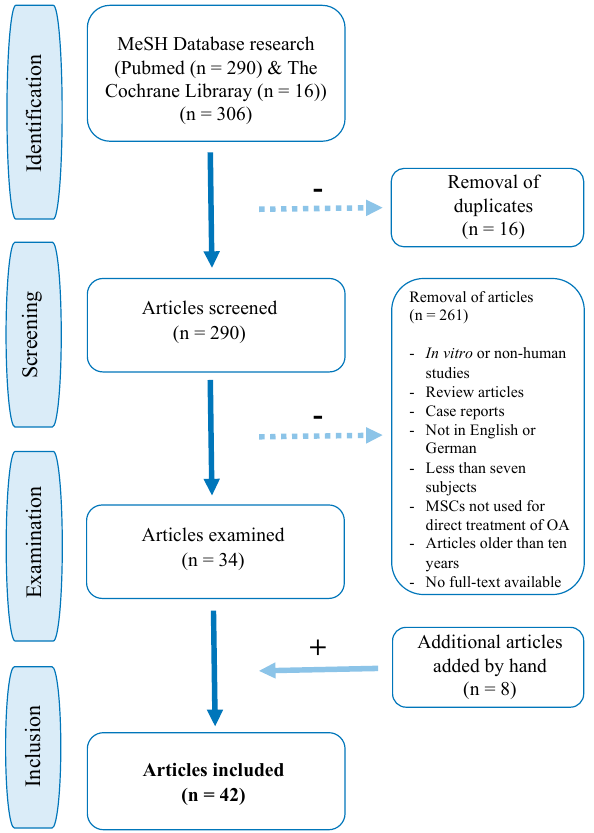
Figure 1. Flow chart of PubMed and The Cochrane Library study selection.